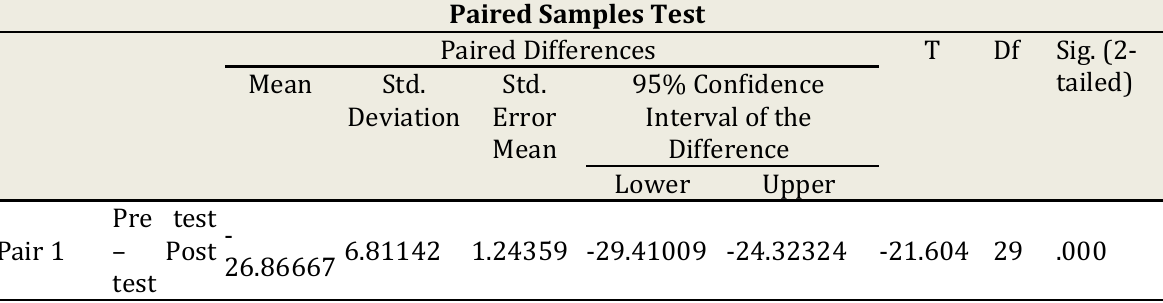
Table 3. The Paired Samples Test of Pre-Test and